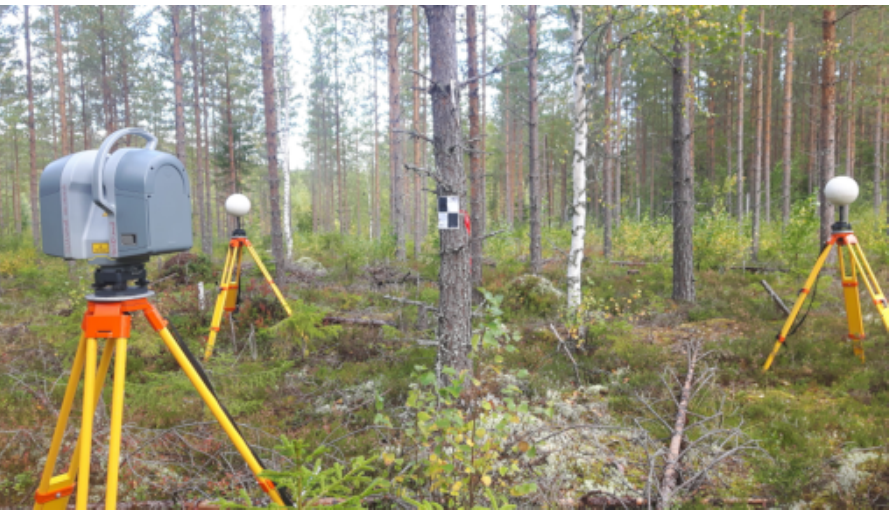
Figure 2. Terrestrial laser scanner experimental setup. The white spheres are targets used when co-registering laser datasets from different scan angles. The black and white sheet on the tree is a target used when co-registering laser data and manually sampled